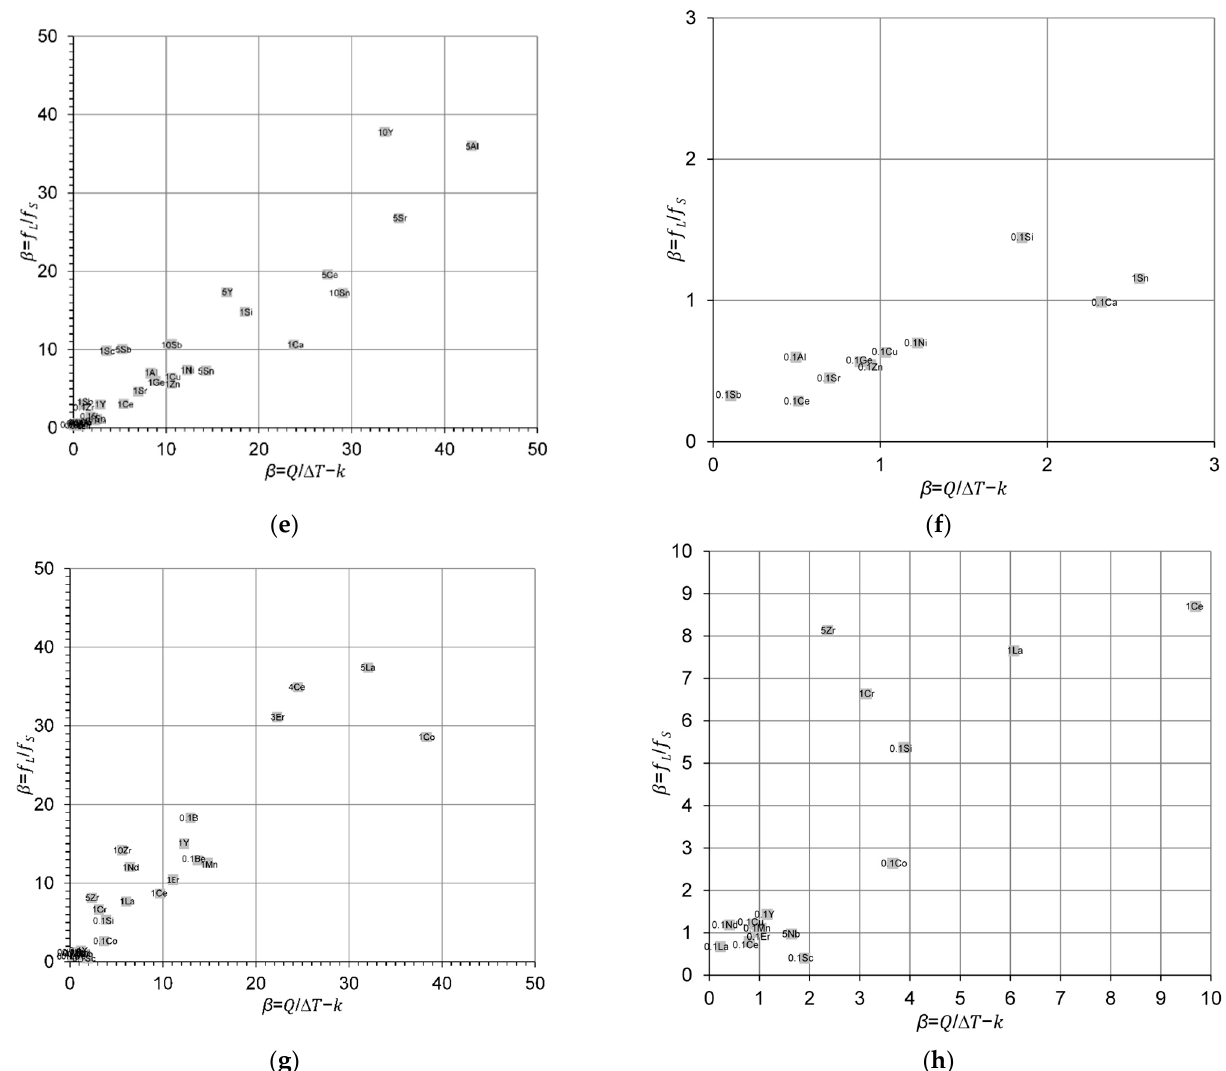
Figure 3. Comparison between the approximated and true β values calculated from Equations (1) and (3), respectively, for ( a , b ) Cu–X; ( c , d ) Al–X; ( e , f ) Mg–X; and ( g , h ) Ti–X binary alloys and zoom-in regions. The reader is referred to the web version of this article for alloy compositions given in data-point labels.